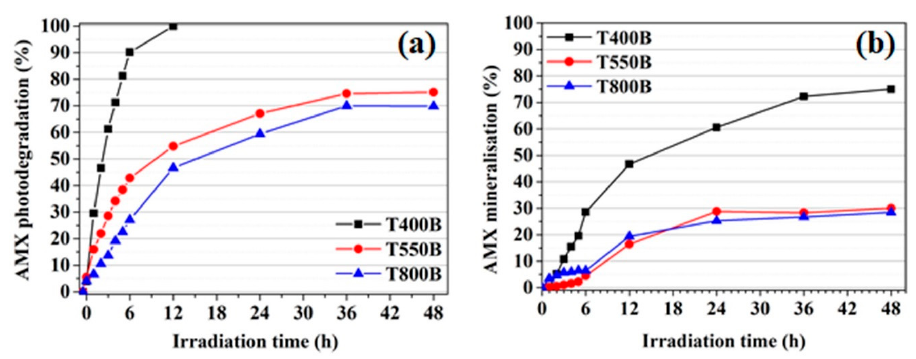
Figure 9. ( a ) The c/c 0 versus irradiation time curves of black TiO 2 for long-term AMX photodegrada- tion. ( b ) The AMX mineralization efficiency for long-term degradation over black TiO 2 photocata- lysts.